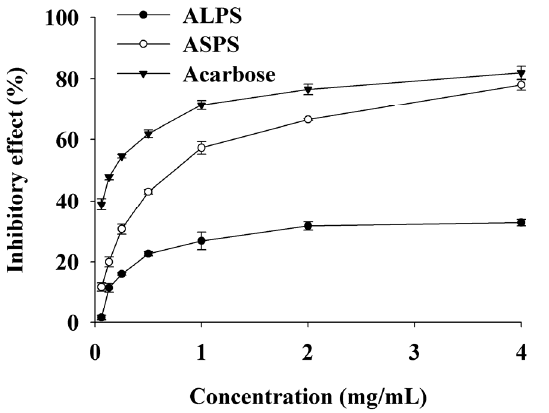
Figure 2. Inhibitory effects of ALPS and ASPS on α